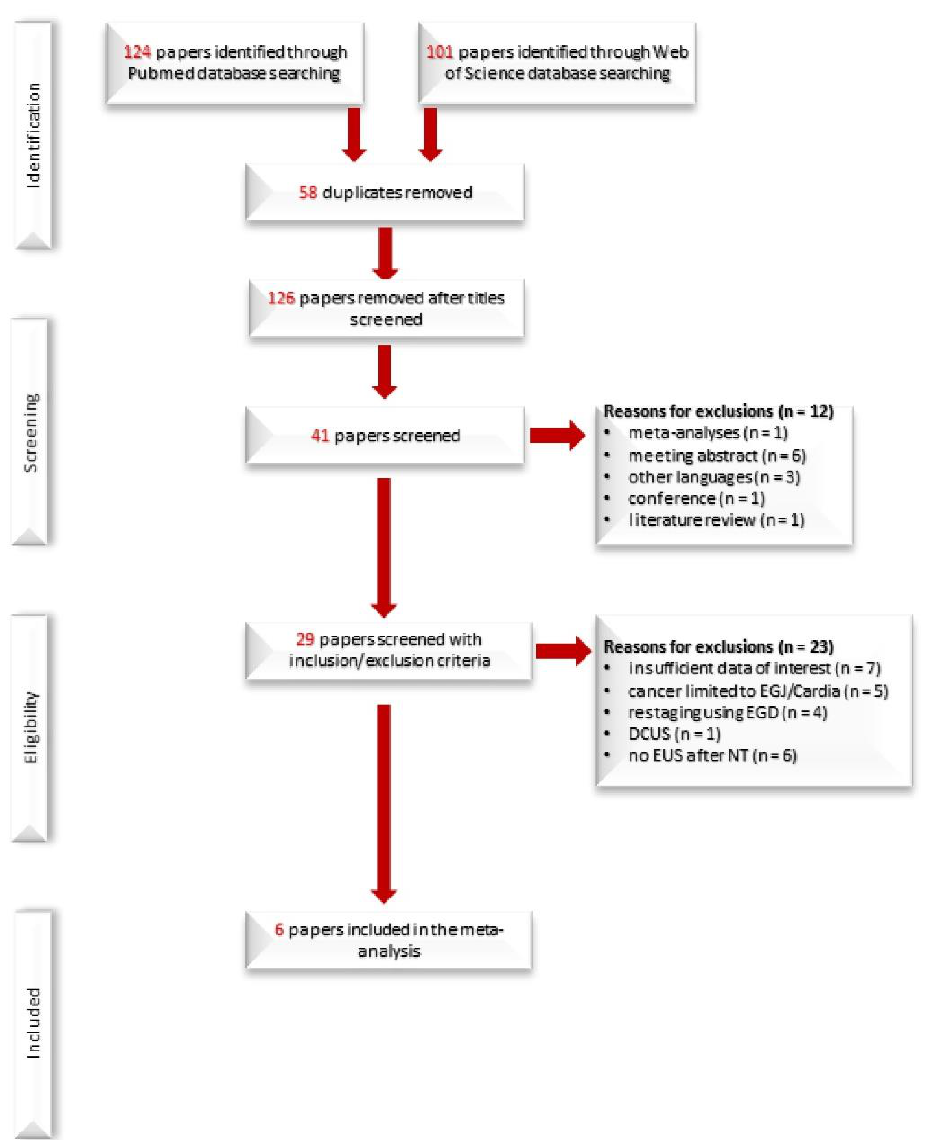
Figure 1. Study flow PRISMA diagram.